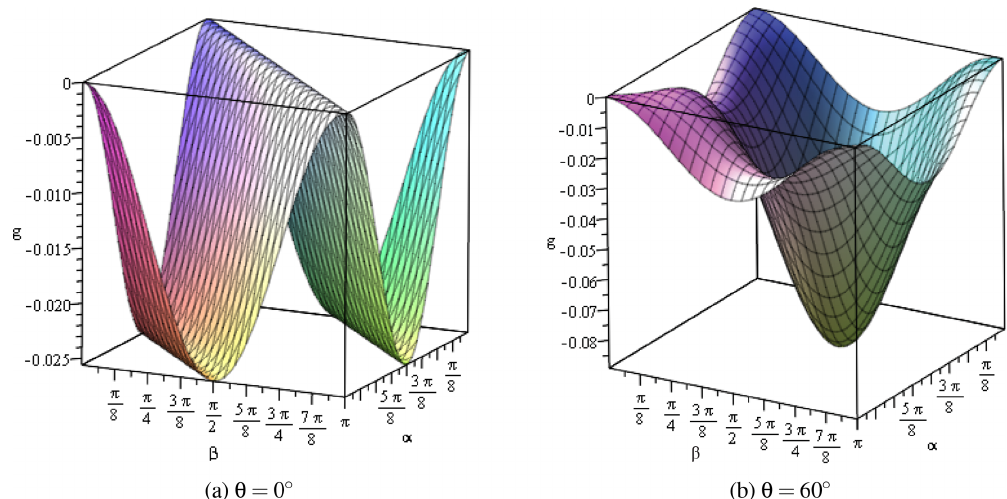
Figure 2. 3-D surfaces of g as a function of α and β for a specified θ